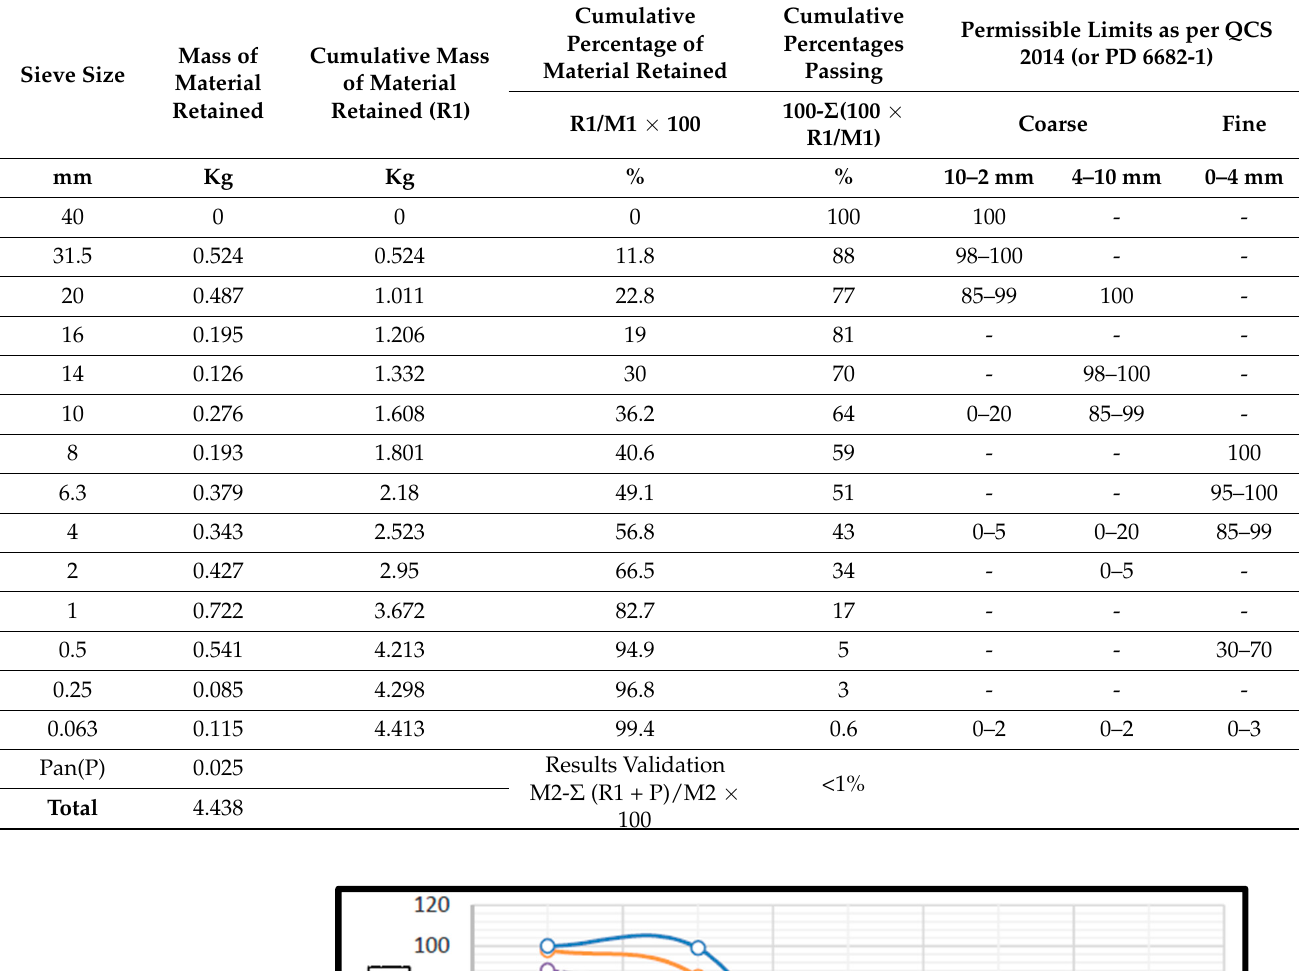
Table 1. Particle Size Distribution (PSD) of muck when considered for use as concrete aggregates.